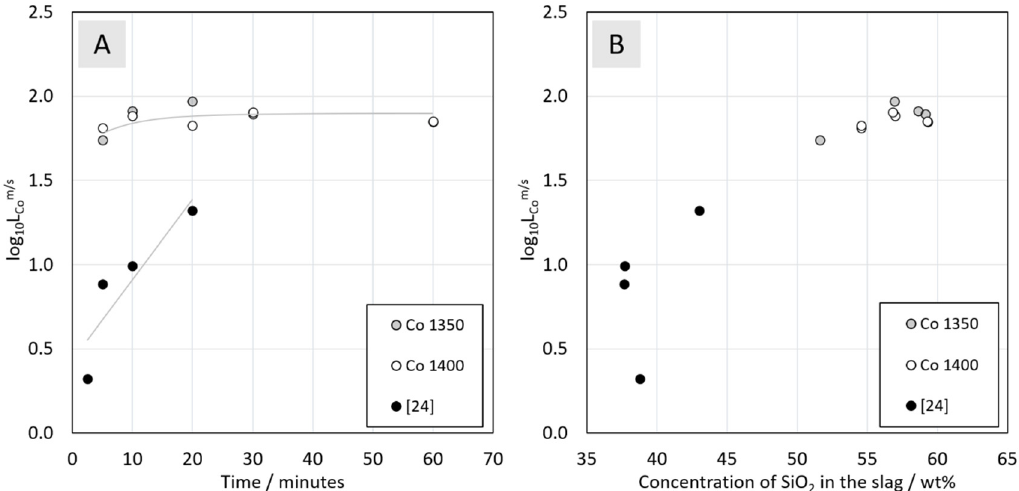
Figure 15. Apparent distribution coefficient of cobalt between the forming metal alloy and the slag ( A ) as a function of reduction time, ( B ) as a function of SiO 2 concentration in the slag.